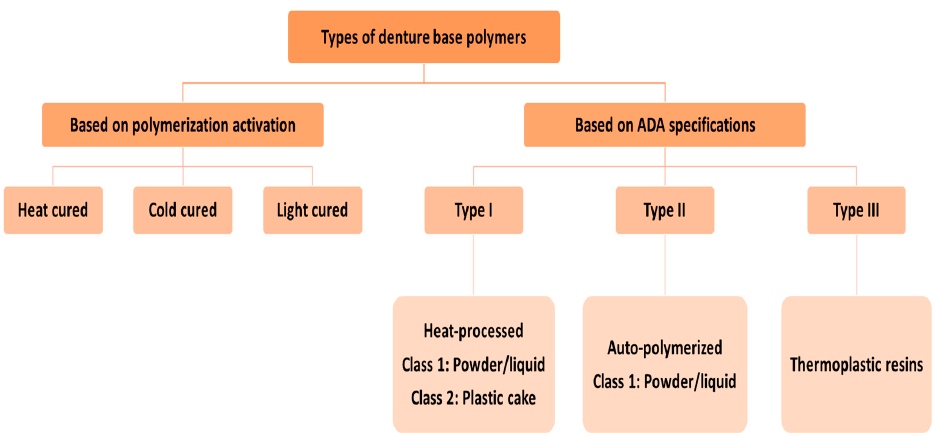
Figure 1. Classification of denture base polymers based on polymerization activation and according to the ADA specifications.